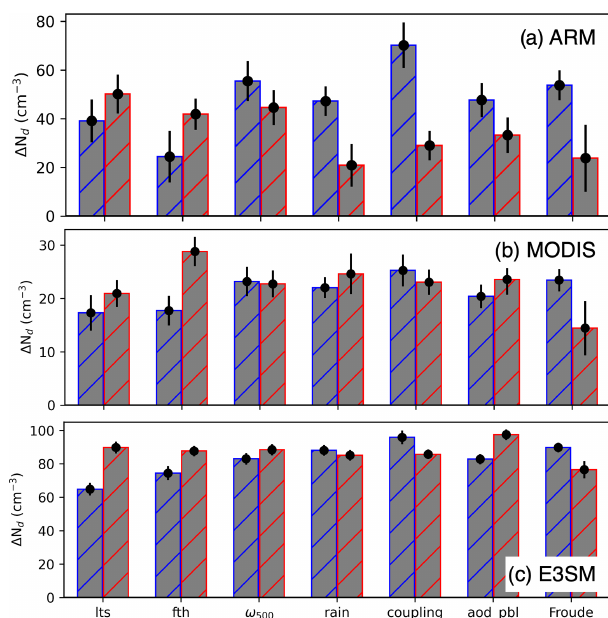
Figure 9. Difference in cloud droplet number concentration ( (cid:49)N d ) between polluted (CCN > 110cm − 3 ) and clean (CCN < 110cm − 3 ) trajectories within 6h of the CCN measurement for (a) ARM, (b) MODIS, and (c) E3SM. Data are stratified by below (blue) and above (red) median lower tropospheric stability (LTS), free- tropospheric humidity (FTH), vertical velocity at 500hPa ( ω _500), rain rate (non-raining and raining), coupling strength (coupled and non-coupled), amount of aerosol in the PBL (aod_pbl), and Froude number (values 0–1 and 1–2). Error bars represent the 95% con- fidence interval computed from a two-tailed t test. Hatching de- notes statistically significant differences. Note that the range in (cid:49)N d varies for each data